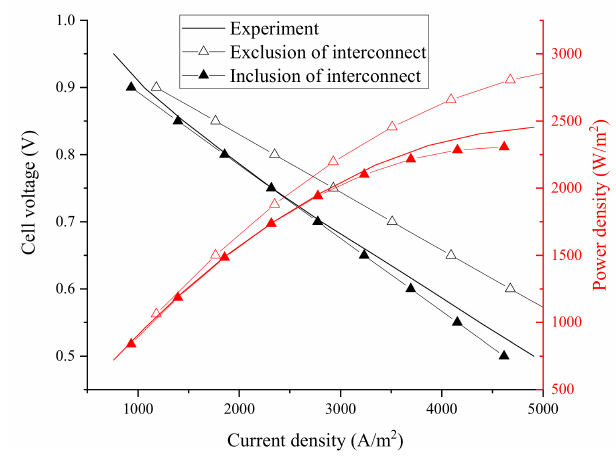
Figure 4. Comparison of main SOFC performance parameters.